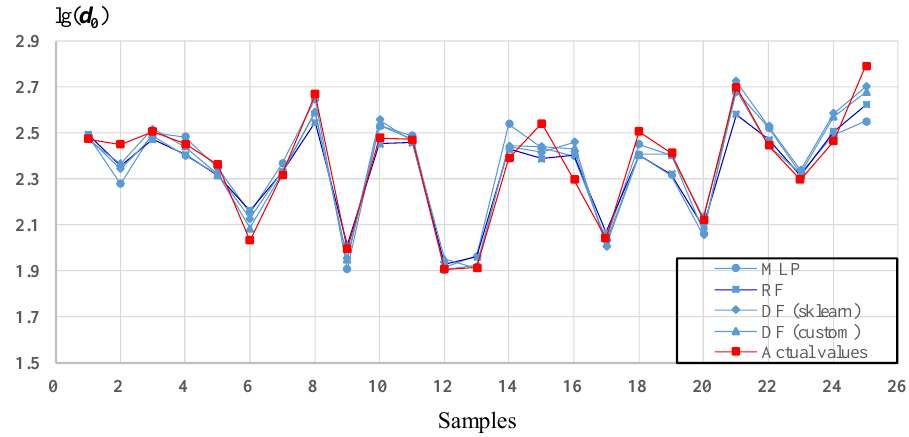
Figure 8. Prediction curves of MLP, RF, DF (sklearn), and DF (custom).